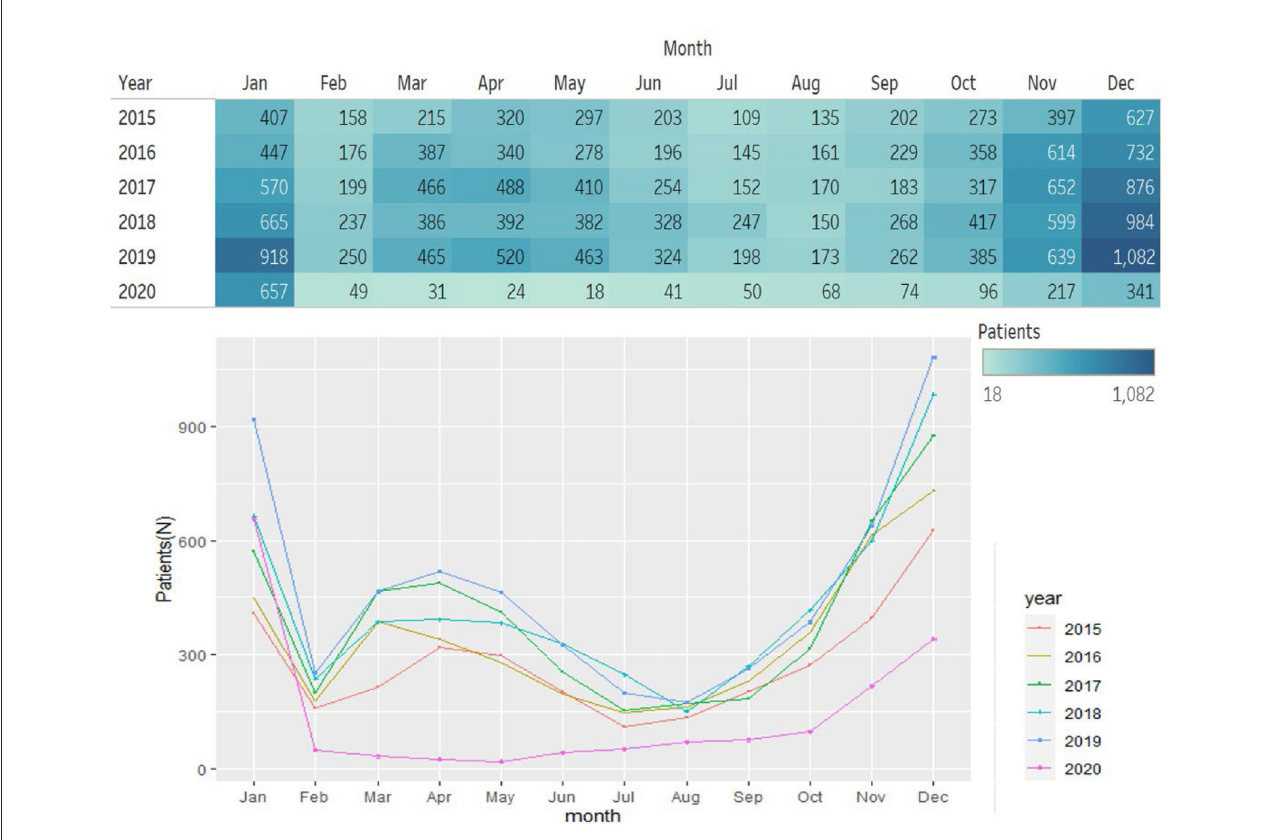
FIGURE1 Number of AOM outpatients per month in